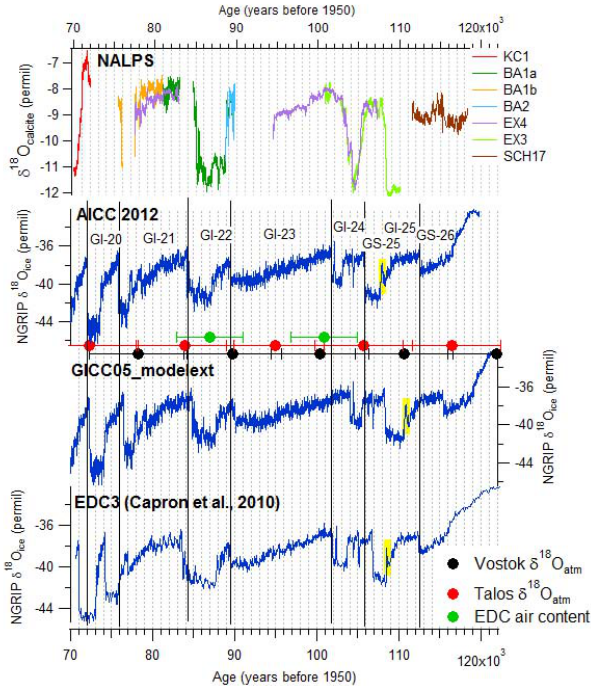
Fig. 3. Comparison of the NGRIP δ 18 O ice evolution over the glacial inception on three different time series in use; top panel: AICC2012 (this work); middle panel: GICC05modelext (Wolff et al., 2010); bottom panel: EDC3 (Capron et al., 2010). The yellow highlight shows the location of the rebound event at the end of GI-25. The grey, vertical lines mark the major GS/GI transitions. The circles mark the orbital points with associated error bars ( δ 18 O atm Vos- tok in black; δ 18 O atm TALDICE in red; air content EDC in green). Note that the δ 18 O atm orbital points were taken at mid-slopes for TALDICE (Bazin et al., 2013) and at minima and maxima for Vos- tok (Suwa and Bender, 2008). The speleothem color-coded compos- ite NALPS δ 18 O calcite record (Boch et al., 2011) is also shown for comparison.